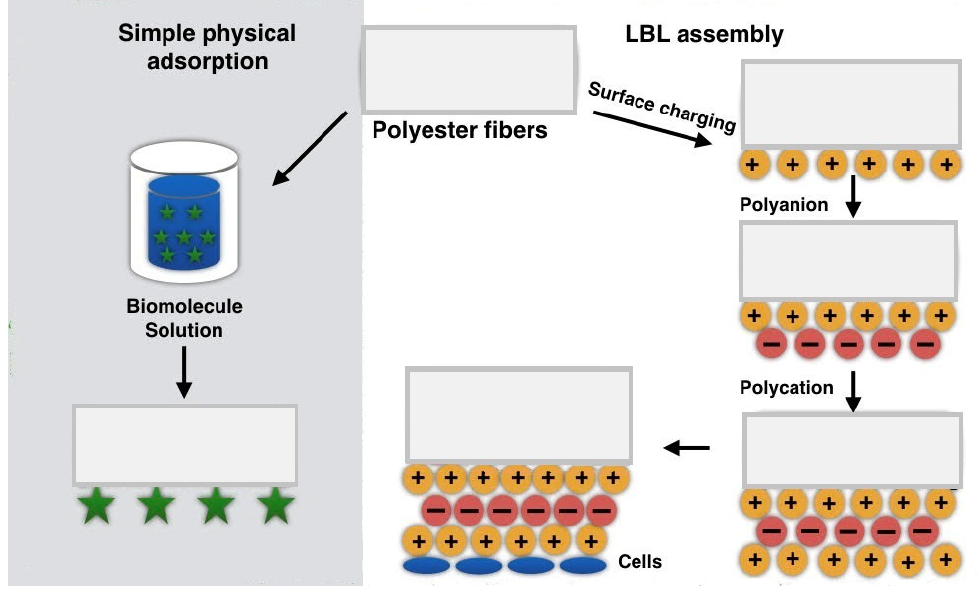
Figure 3. Physical functionalization of electrospun nanofibers.